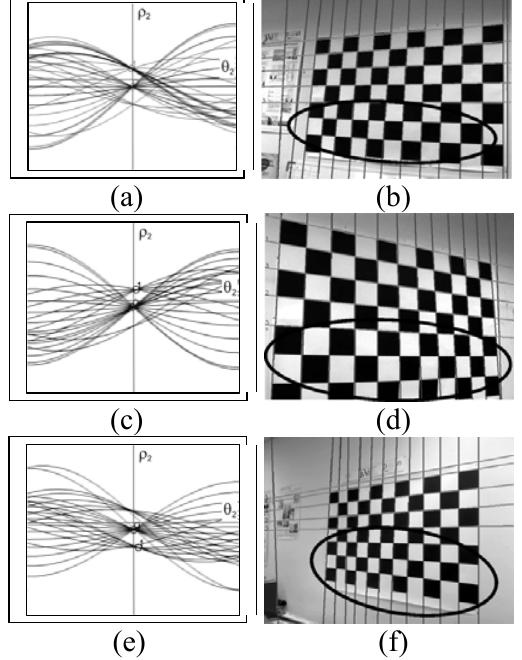
Figure 9. (a-c-e) sets of lines (b-d-f) lines whose distance is small according to